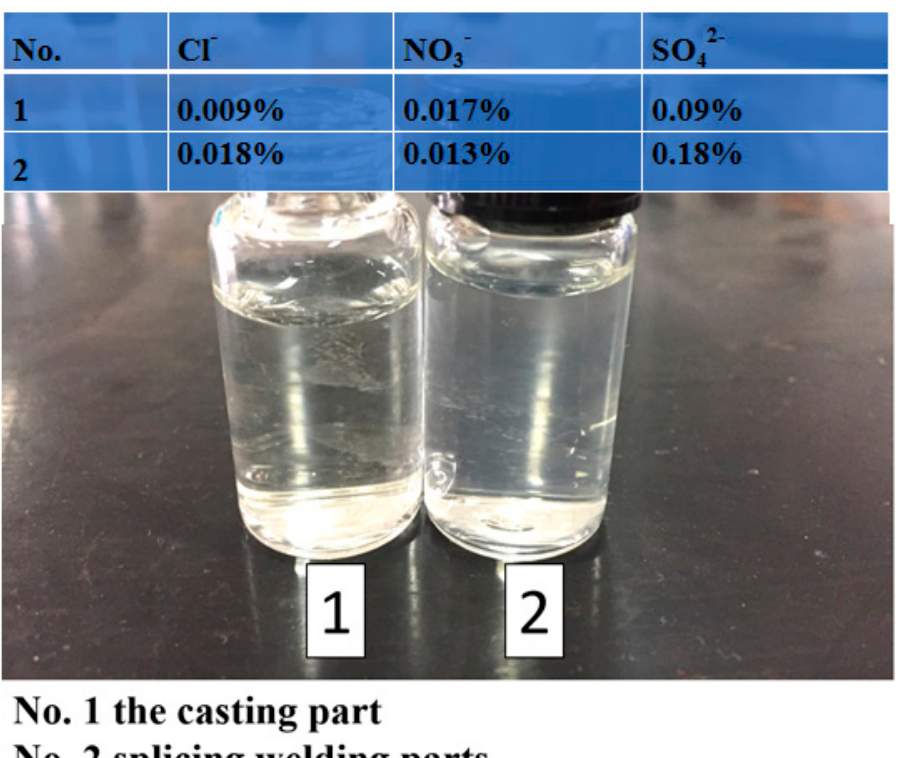
Figure 5. The ion chromatography and titrating with silver nitrate solution results.